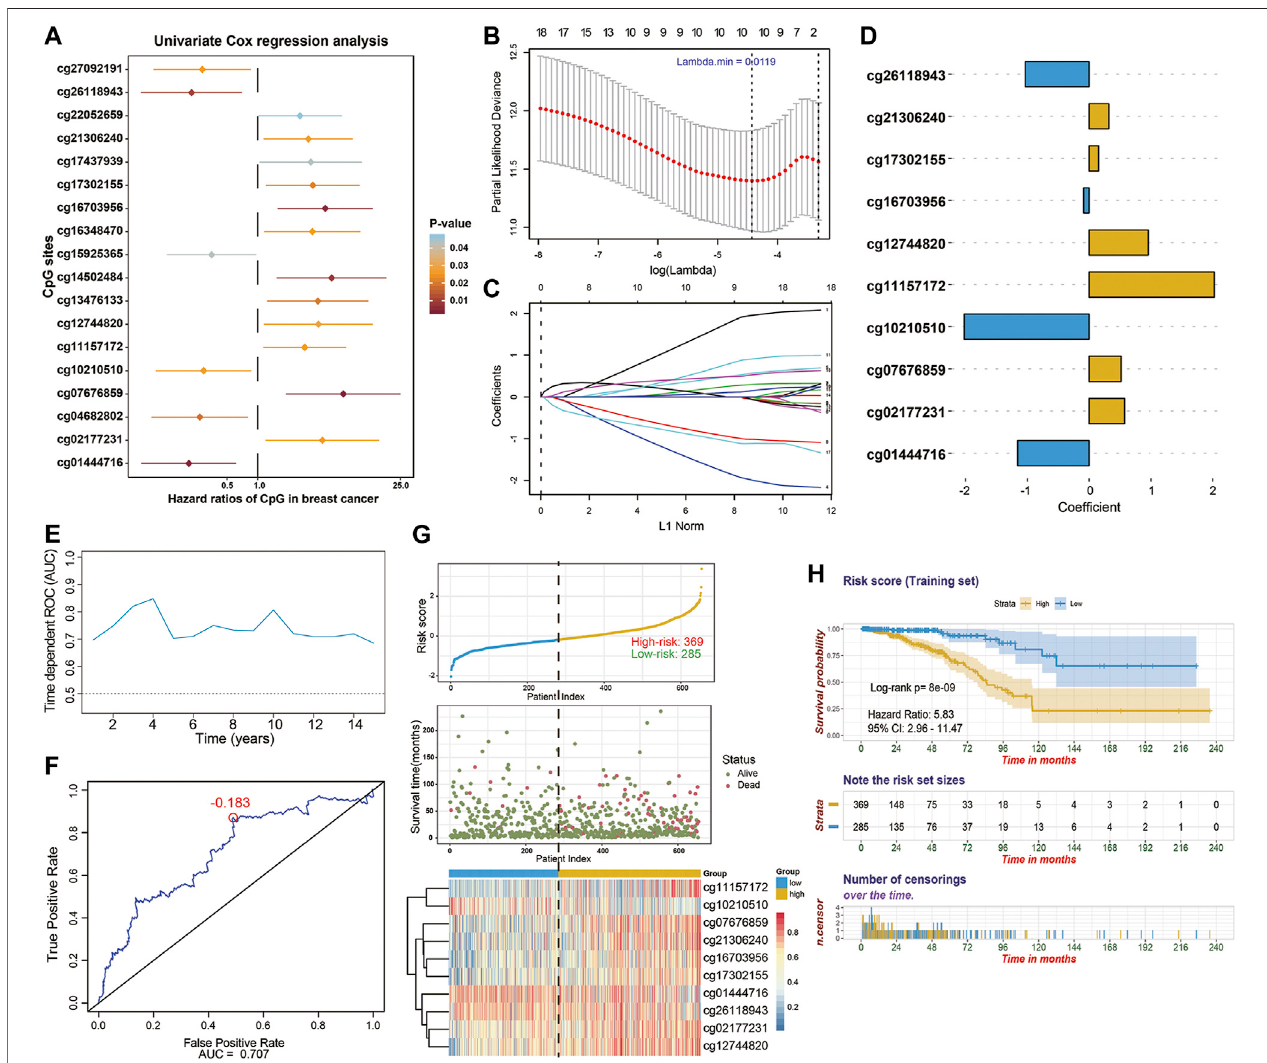
FIGURE3| Identi fi cationof10-CpG-basedprognosticsignatureinthetrainingstage( n (cid:1) 654). (A) Forestplotwhichdepictsthe18signi fi cantlysurvival-associated CpG sites ( p -value < 0.05) among the cancer-speci fi c methylation locus in the training set. Unadjusted hazard ratios (boxes) and 95% con fi dence intervals (horizontal lines)ofunivariateCoxregressionanalysesarepresentedintheplot. p -valuesareindicatedbythecolorscalebytherightside. (B) Selectionoftuningparameter(lambda) in the LASSO-penalized Cox model via 10-fold cross validation in the training set. The partial likelihood deviance ( y -axis) from the cross-validation procedure of LASSOregressionisplottedasafunctionoflog(lambda)(lower x -axis).Dynamicallychangingnumberalongtheupper x -axisindicatestheaveragenumberofpredictors. Dashedverticallinesfromrighttoleftde fi nethelogarithmoftheoptimalvalueoflambdavia “ 1-foldstandarderror ” and “ minimum ” criteria,respectively. (C) Theshrinkage procedure of regression coef fi cients of predictors in (B) . The optimal lambda value of 0.0119 was chosen based on the “ minimum ” criteria and 10-fold cross validation. The 10 resulting predictors with nonzero coef fi cients were subselected as candidates for model construction. And the numbered lines represented the corresponding CpG sites in y -axis of the (A) from top to bottom, respectively. (D) Coef fi cients of CpG sites derived from the multivariate Cox regression analysis, which were used for calculatingtheriskscore. (E) Theperformanceofthemodelintrainingset.Dynamicallytime-dependentROCcurveswithAUCvaluesestimatedfrom1 yearto15 years. (F) The5-yearsROCcurveanalysesfortheriskscorederivedfromthe10-CpG-basedsignature.Thereddotrepresentsthecorrespondingoptimalcutoffvalue( − 0.183), which were calculated based on the Youden index. (G) The distribution of patients ’ survival status ranked by corresponding risk score, the methylation pattern of correspondingCpGsitesincludedin fi nalsignature, (H) Kaplan-Meiercurvesofoverallsurvivalbetweenlow-andhigh-riskpatientsstrati fi edby10-CpG-basedsignature in the training cohort. Log-rank test, p -value < 0.0001.